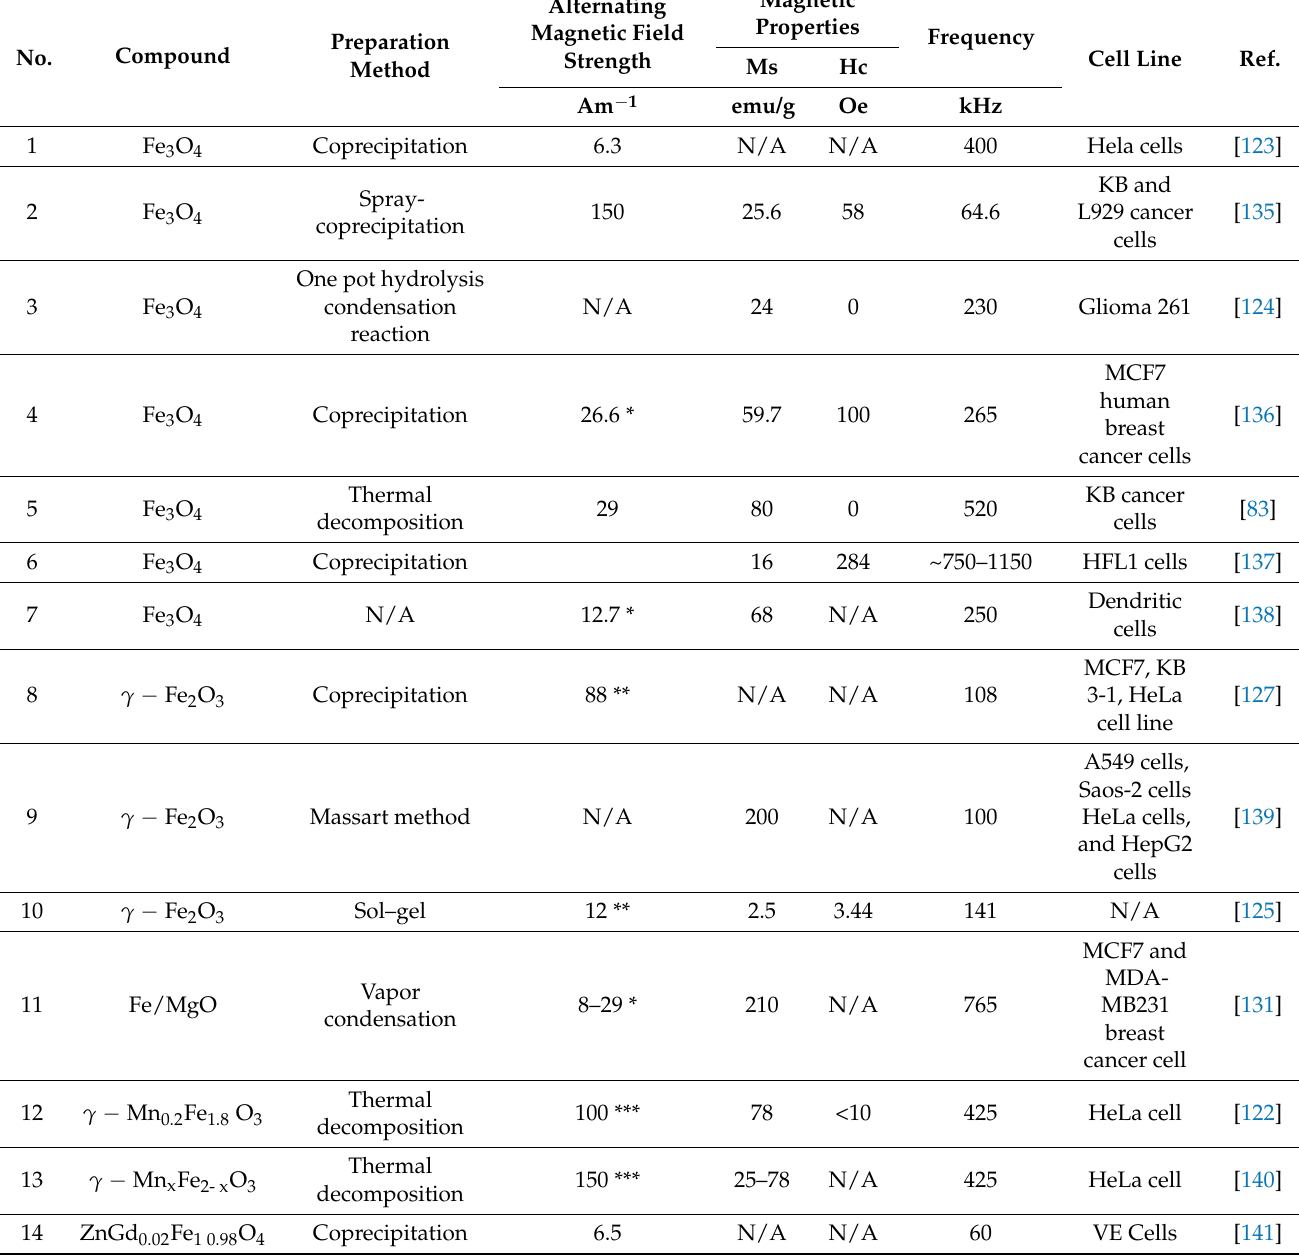
Table 3. Overview of typical examples of magnetic